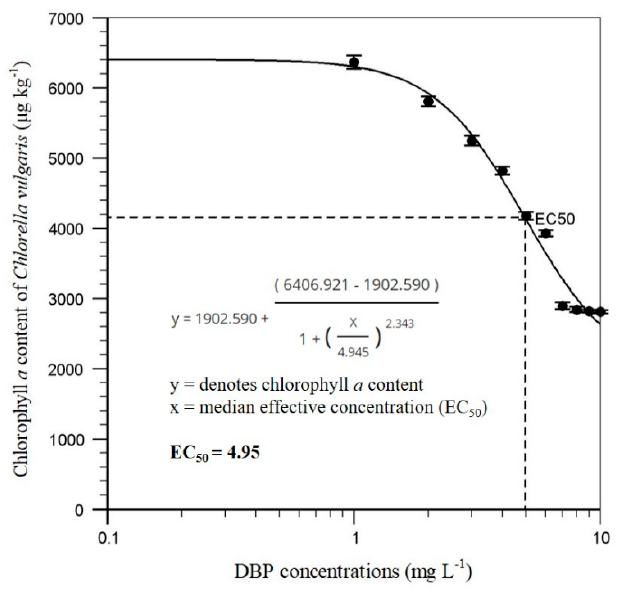
Figure 2. Dose–response curve of algal acute biotoxicity, and 24h-EC 50 of DBP for C. vulgaris . Data from three measurements are presented as mean ± SE.